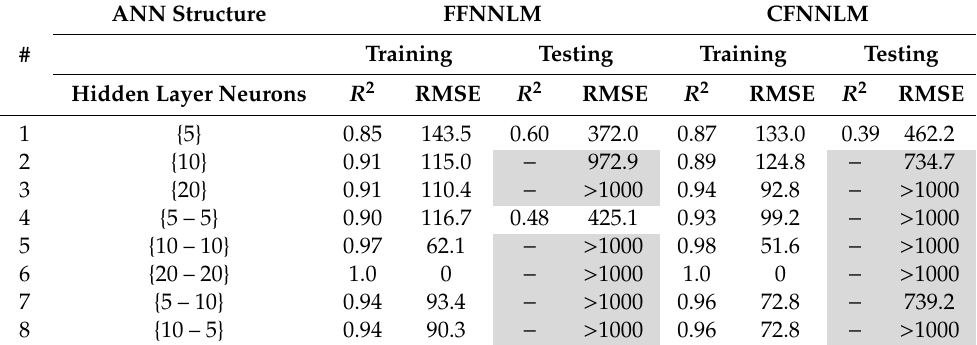
Table 4. Results on ANN trained with 4 features ( x 1 , x 2 , x 4 , x 5 ) using the Levenberg–Marquardt (LM)